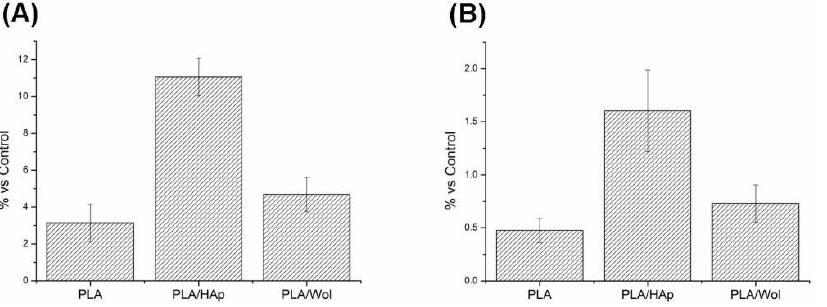
Figure 7. Fluorescence of live E. coli bacteria on the surface of samples ( A ) and the ratio of live and dead bacteria adhered to the surface ( B ).